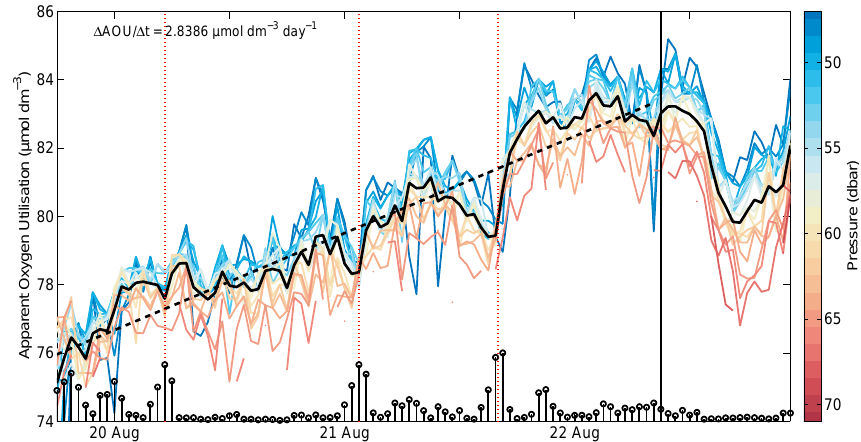
Figure 7. Seaglider apparent oxygen utilization (µmoldm − 3 ) along isobars at 1dbar intervals from 45 to 71dbar, coloured by pressure. Black vertical lines indicate the maximum difference in temperature at each time step as shown in Fig. 8. Binned data from the BML (45dbar and below) are plotted against time and coloured by pressure to highlight any vertical gradients. The dotted vertical lines indicate when vertical mixing events were evident. The vertical black line indicates the transition to a different water mass.